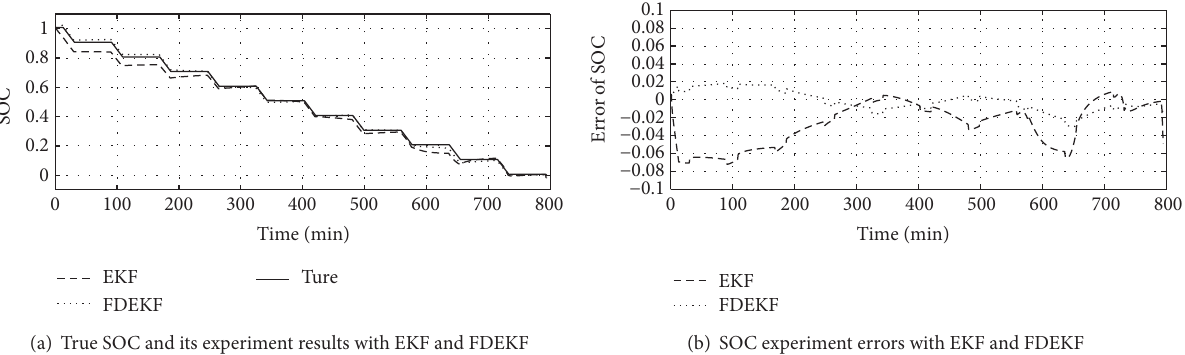
Figure 6: Comparison of SOC estimation and error curve of constant-current discharge pulse.